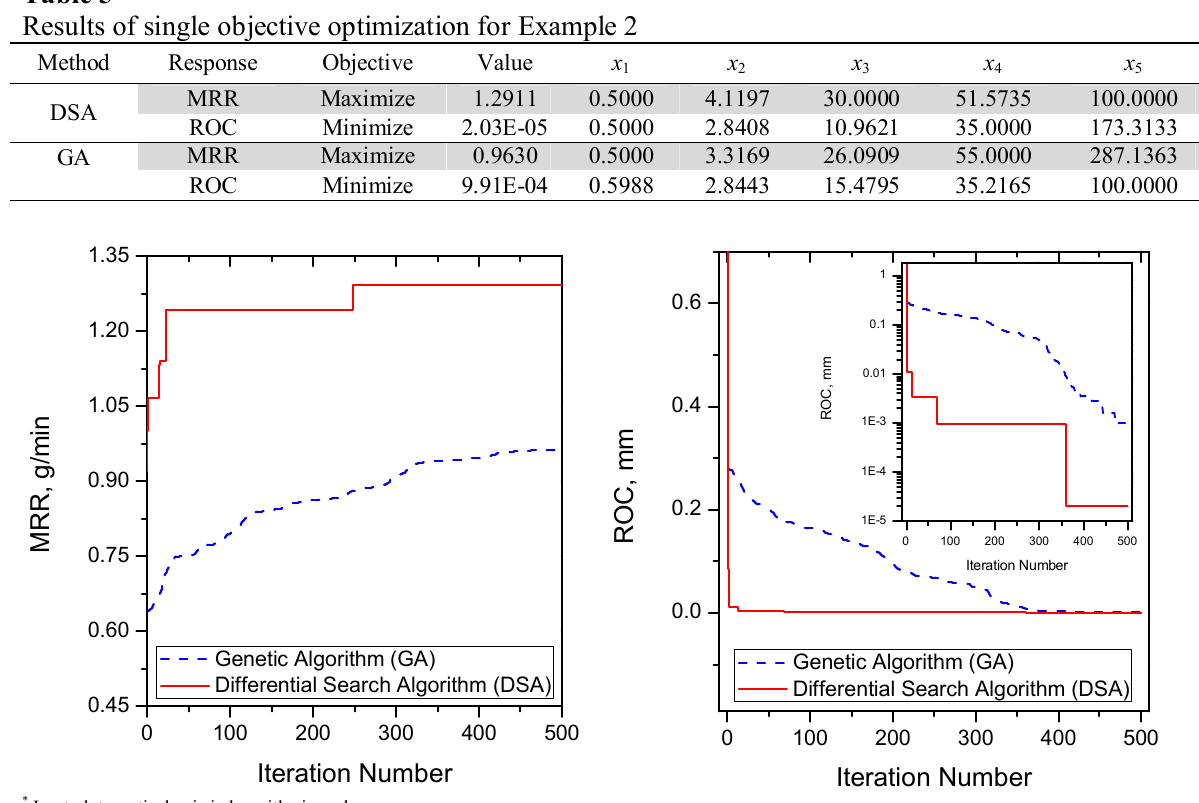
Fig. 4. Convergence diagrams of DSA and GA for Example